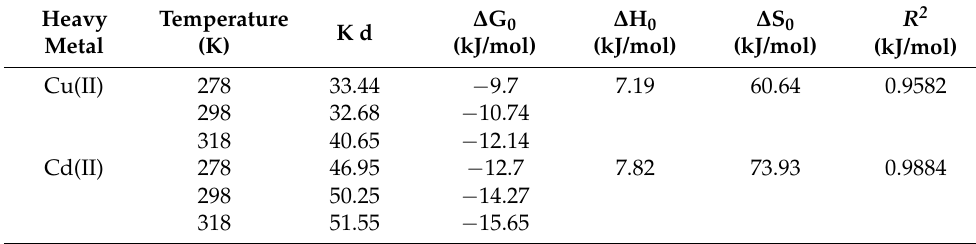
Table 8. Thermodynamic parameters of adsorption on KAM500-400-3 absorbing Cu(II)/Cd(II).